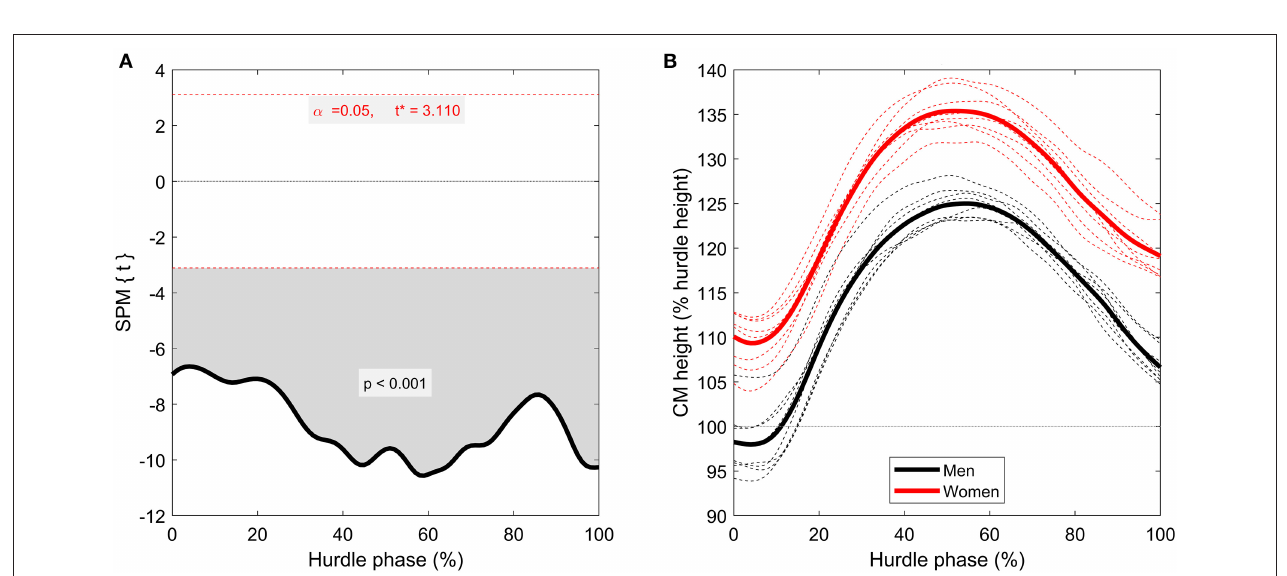
FIGURE 4 | Time-series comparison between men and women for CM anteroposterior velocity (computed as a percentage of “entry velocity” [i.e., velocity at TD pre ]). The left-hand figure (A) contains the SPM t -statistic curve, and the right-hand figure (B) contains grouped mean curves (thicker, solid lines) as well as individual athlete data (thinner, dashed lines) for men (black lines) and women (red lines). Gray-shaded regions correspond with suprathreshold clusters detected through SPM.